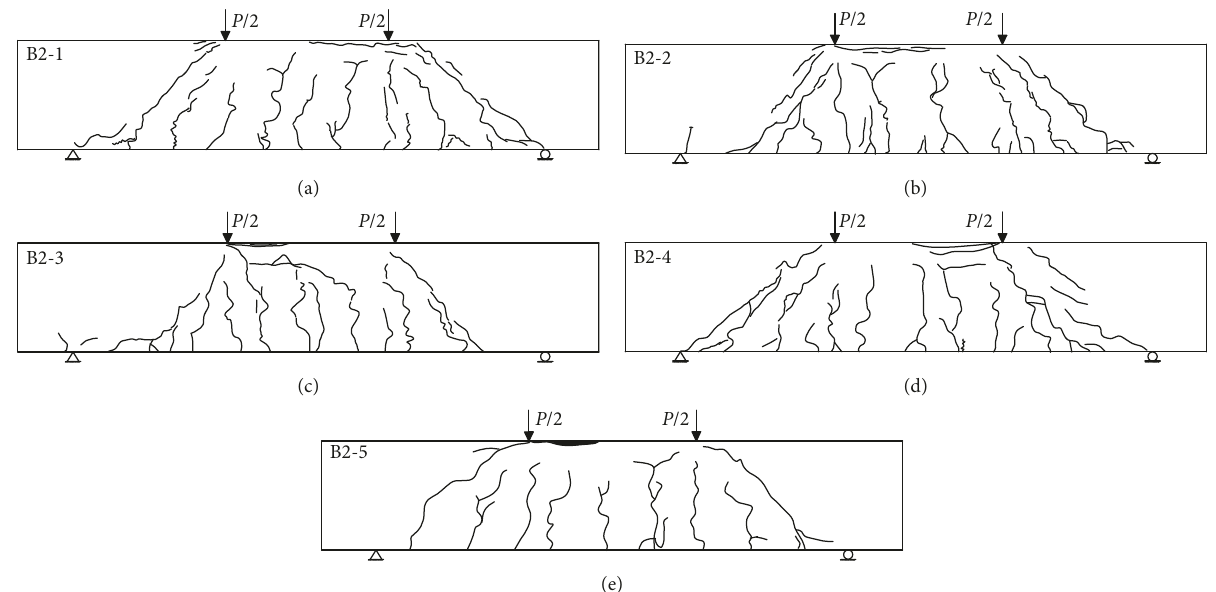
Figure 3: Crack patterns of series B2: (a) B2-1; (b) B2-2; (c) B2-3; (d) B2-4; (e)